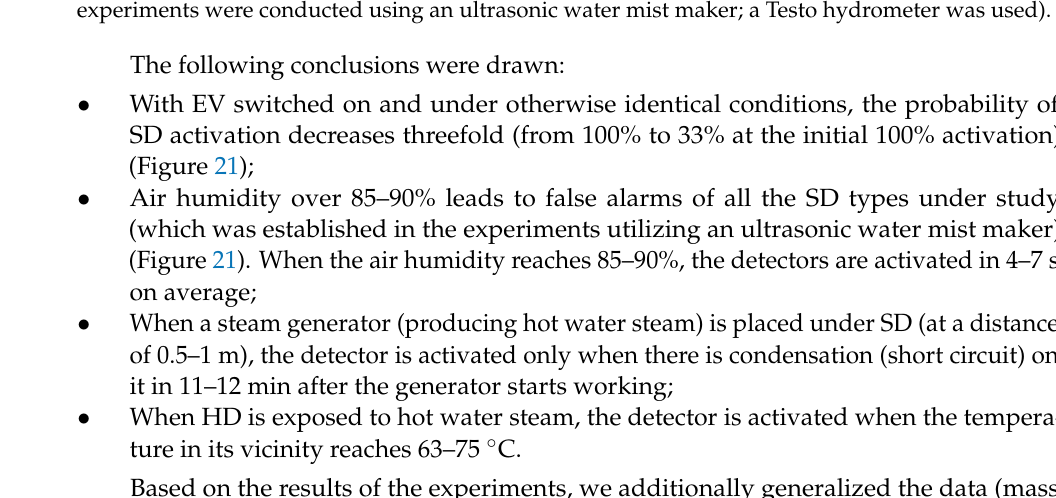
Figure 21. ( a ) Effect of smoke ventilation system on SD activation probability during wood combustion (sample mass 50 g); ( b ) Influence of air humidity on false alarms of smoke detectors (the experiments were conducted using an ultrasonic water mist maker; a Testo hydrometer was used).